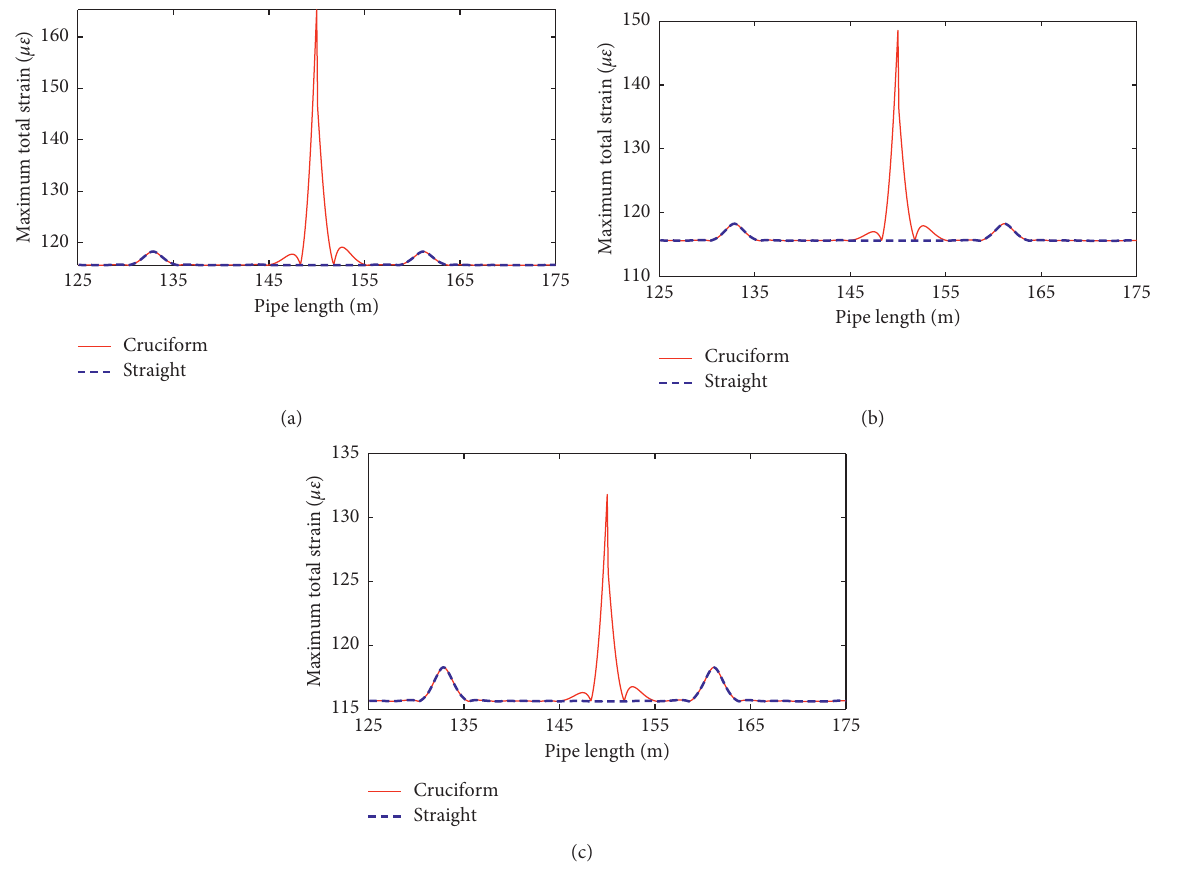
Figure 17: Maximum total strain with different branch angles: (a) 60 ° ; (b) 45 ° ; (c) 30 ° .